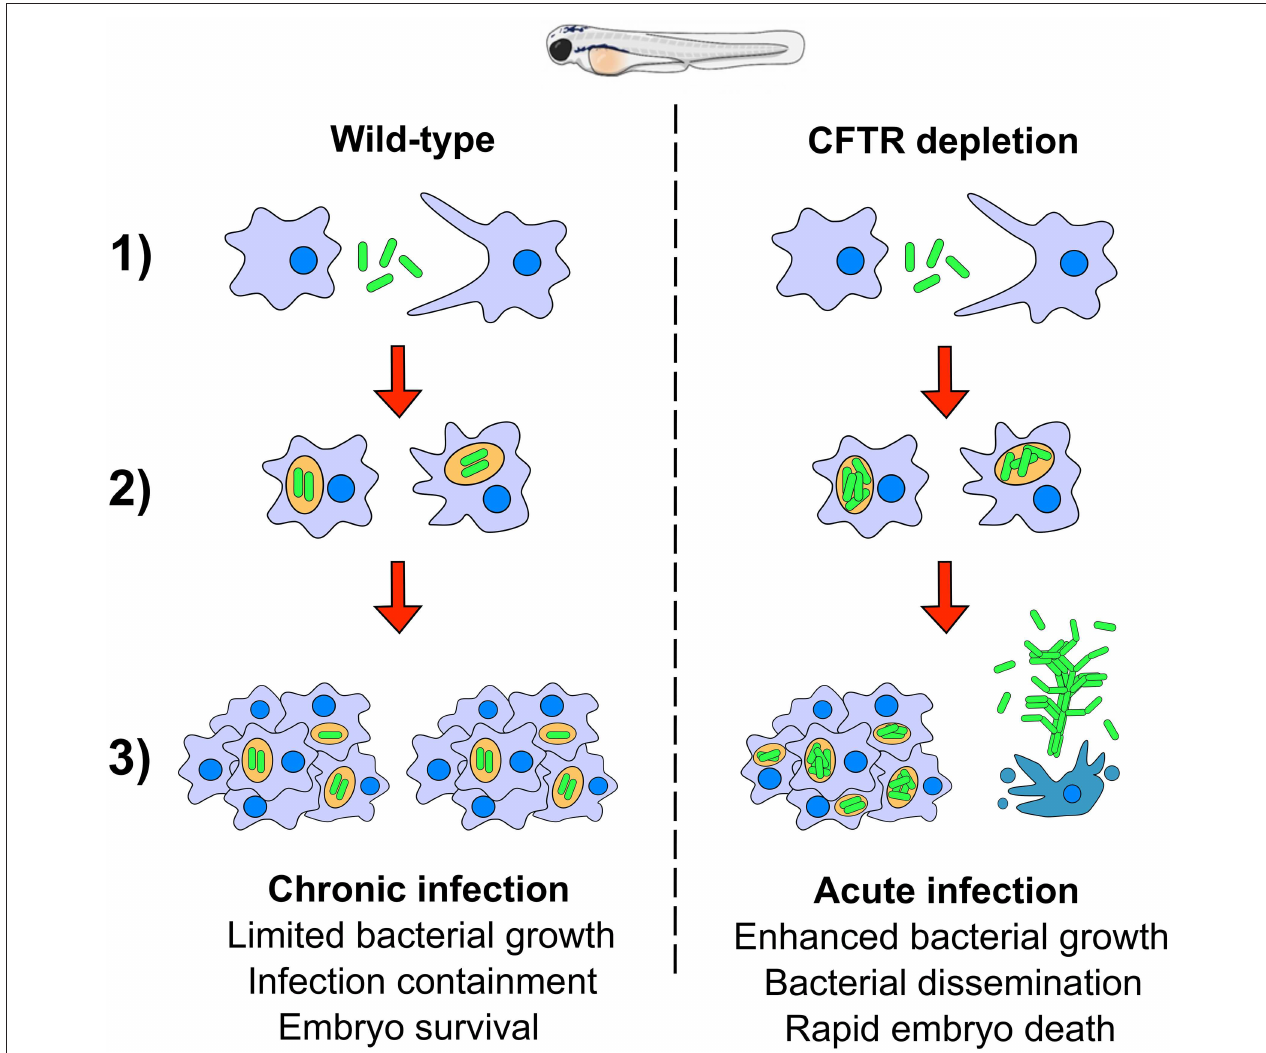
FIGURE 6 | A hypothetical schematic summarizing the pathogenesis of Mycobacterium fortuitum in both wild-type and CFTR backgrounds. (1) Following intravenous injection of M. fortuitum into zebrafish embryos, macrophages are rapidly recruited to the site of infection and phagocytose bacilli; (2) Once inside the phagosome, M. fortuitum is able to initially replicate, however in a wild-type scenario, host defenses are able to slow the bacterial expansion until further macrophages are recruited. Comparatively, following CFTR depletion, bacteria are able to rapidly expand within the phagosome, presumably due to defective host oxidative defense mechanisms. (3) Additional macrophages are recruited to the infection foci, forming the granuloma which acts to contain infection dissemination in wild-type embryos. In a proportion of wild-type embryos, we propose that macrophage apoptosis triggers the escape of bacilli to the extracellular space which facilitates the growth